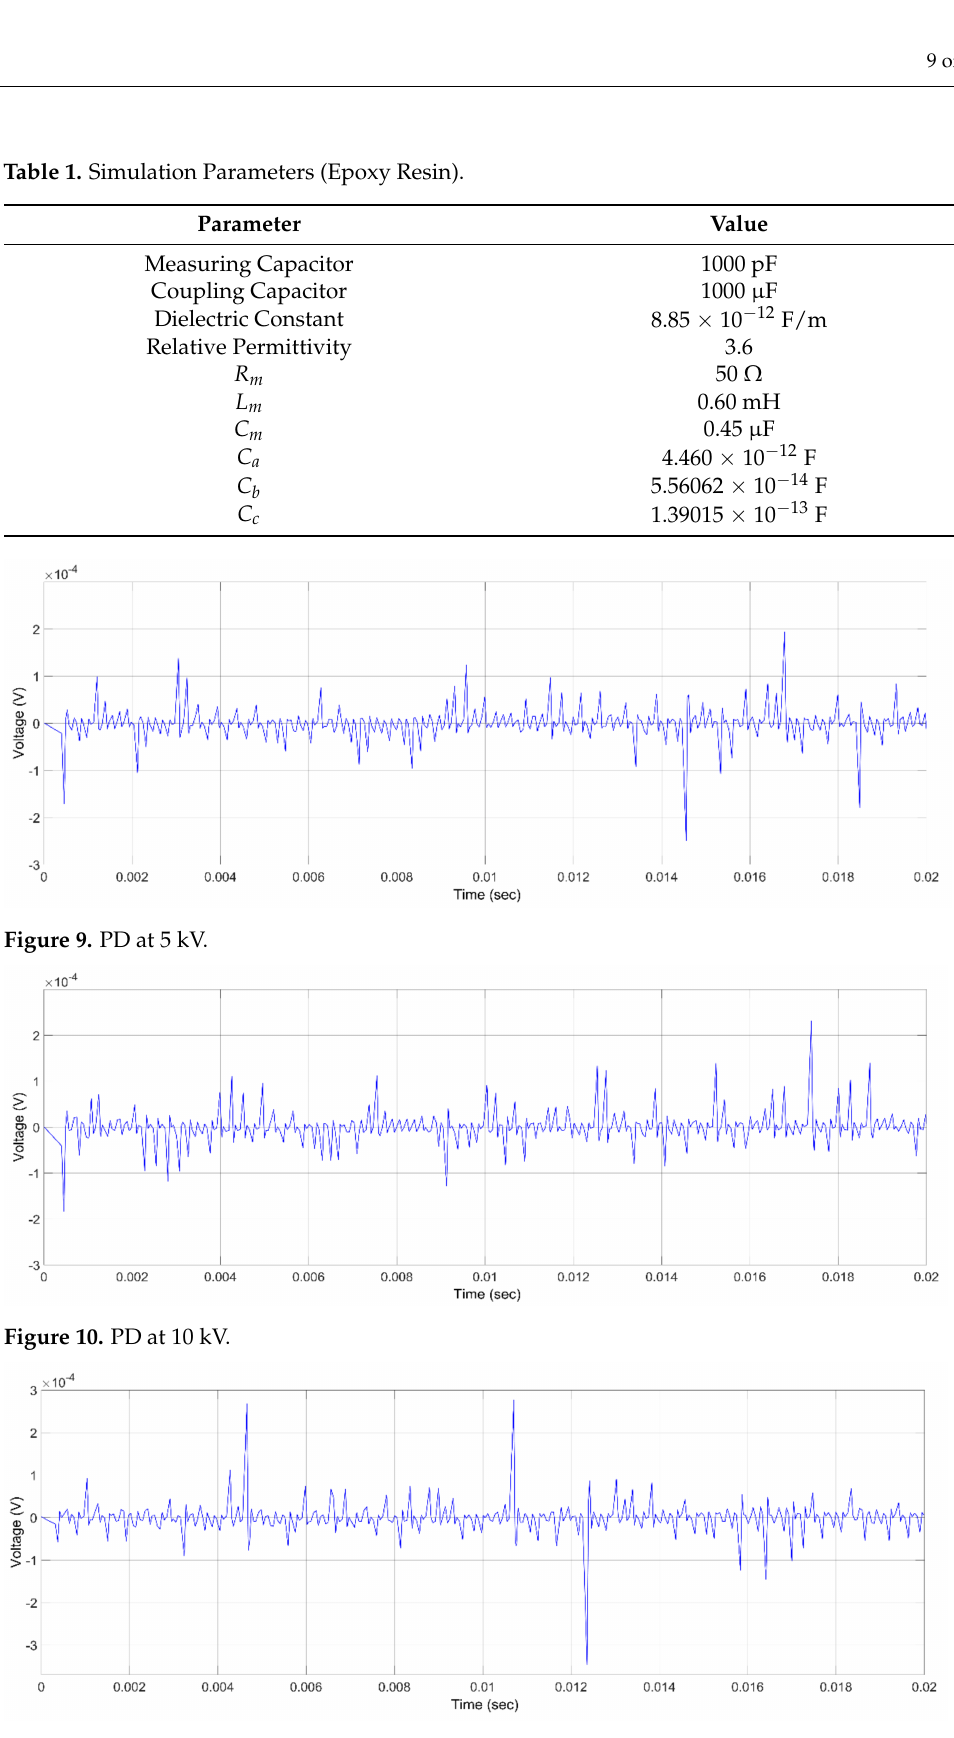
Figure 11. PD at 15